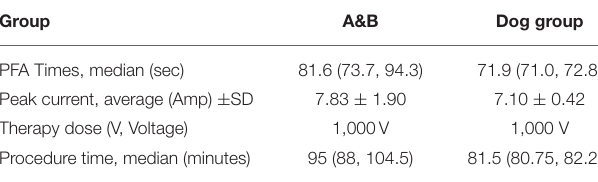
TABLE 1 | Procedural characteristics of biphasic asymmetric PFA.